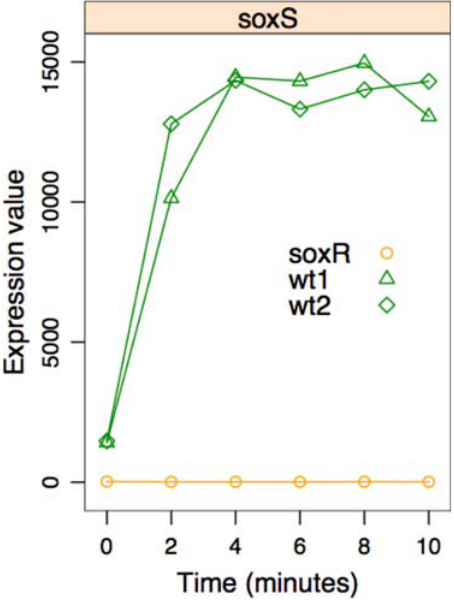
Figure 6. Expression levels of soxSmRNA. soxS mRNA levels as are shown as a function of time in the wild type and the D soxR